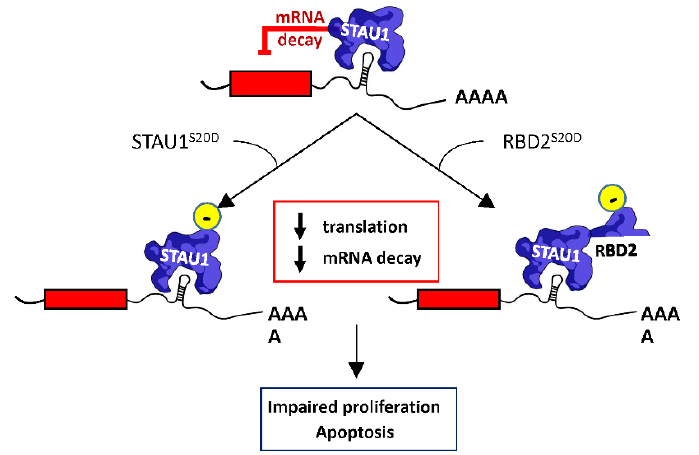
Figure 7. Proposed mechanism of STAU1 55 -mediated cell proliferation impairment . STAU1 55 is a posttranscriptional regulator that controls translation and the SMD of bound mRNAs. Expression of STAU1 S20D inhibits both STAU1-mediated translation and decay. Similarly, the expression of RBD2 S20D abrogates SMD, but the expression of endogenous STAU1 55 is required for this phenotype, indicating that RBD2 S20D interferes with endogenous STAU1 55 functions. As a consequence of the misregulation of STAU1 55 -bound mRNAs following STAU1 S20D or RBD2 S20D expression, cells enter apoptosis or show impaired cell